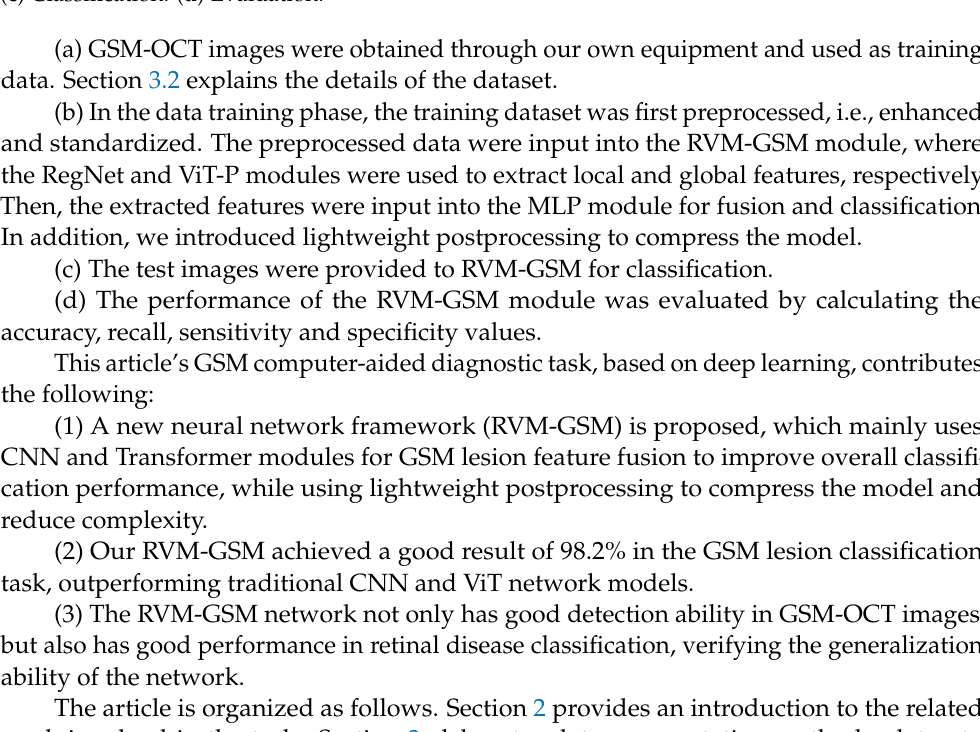
Figure 1. Overall structure of the experimental model. ( a ) Training Data. ( b ) Training process. ( c ) Classification. ( d )